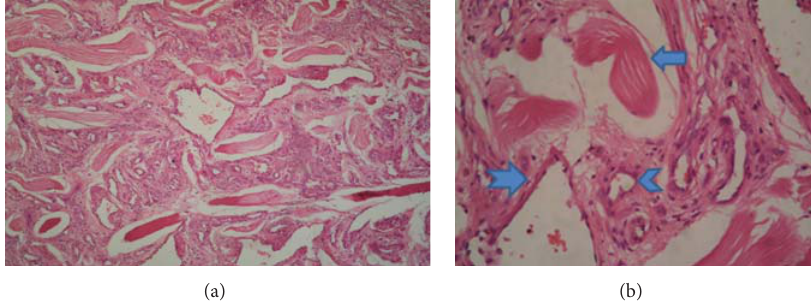
Figure4:(a)Histopathologicalexamination(10xpowers):thefieldshowsnumerouscapillary-sizedvesselsandlargedilatedvesselsextending between skeletal muscle fibers. (b) Histopathological examination (40x powers): skeletal muscle fiber (arrow), capillary-sized vessel (arrow head), and dilated large blood vessel (notched